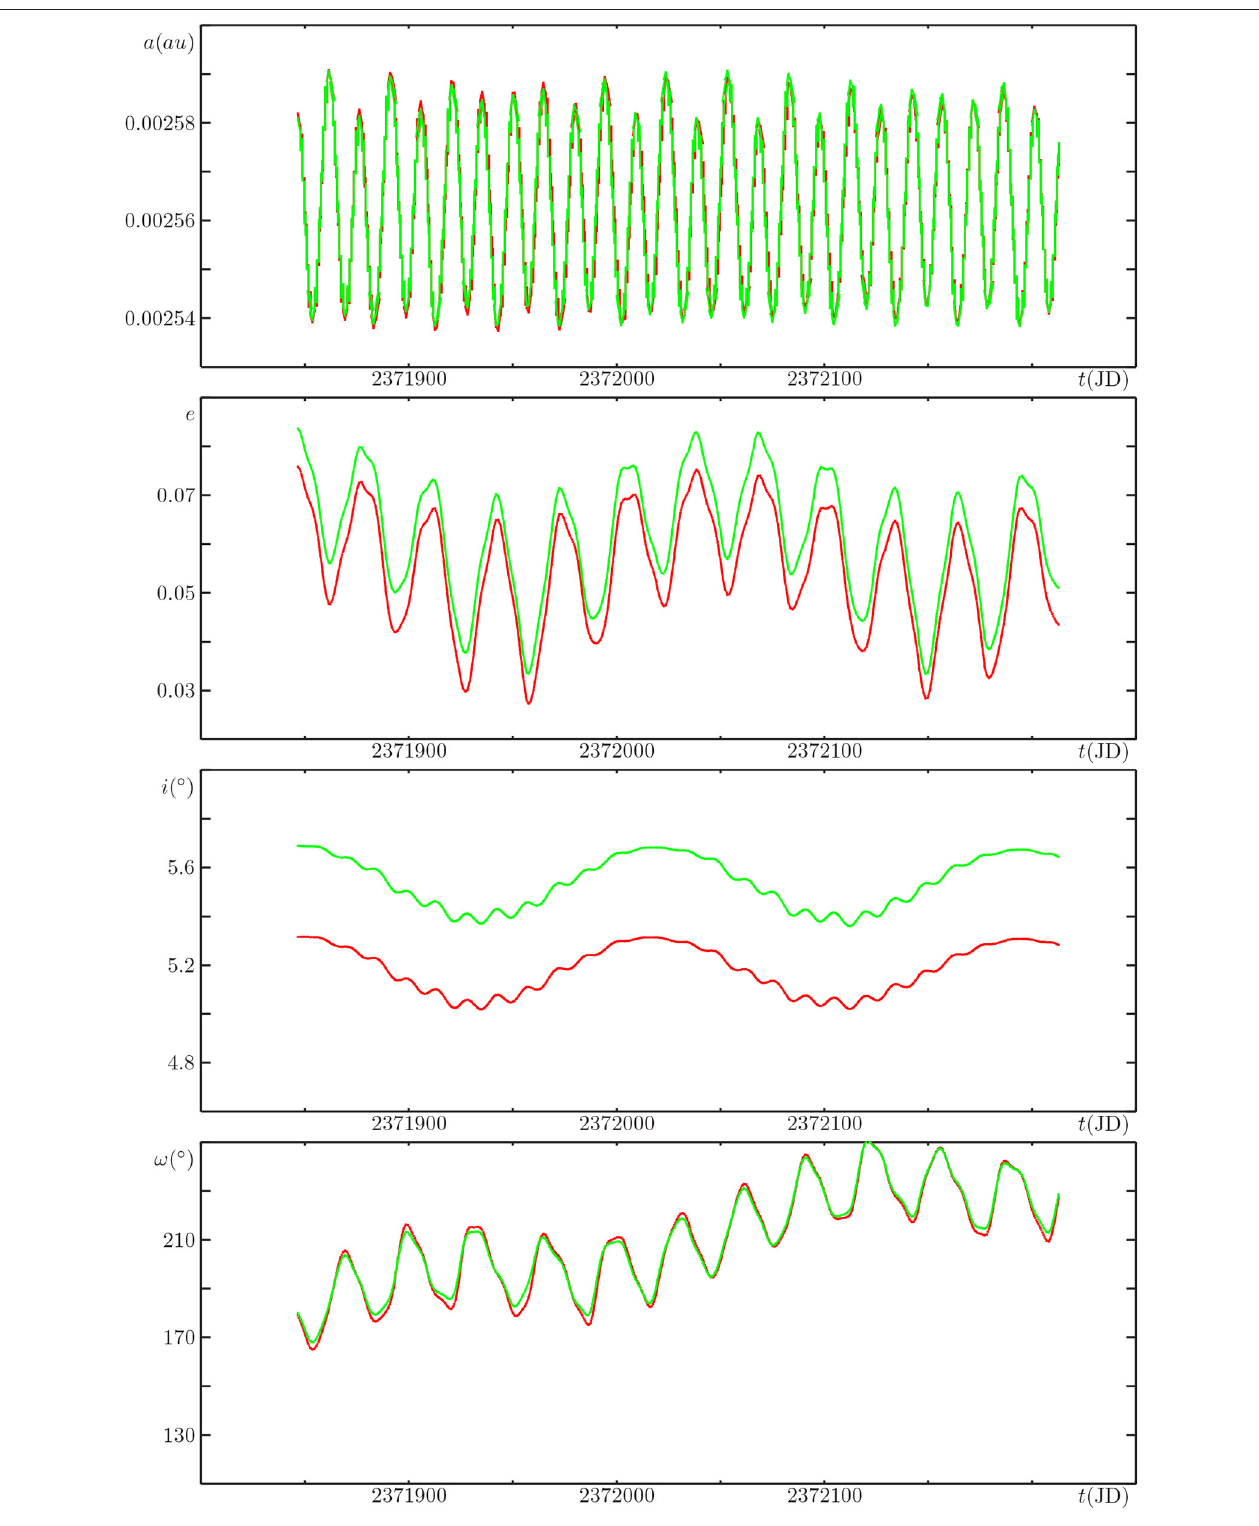
FIGURE 1 | Time evolution of the elements of the Moon taken from JPL DE406 (in red) and for the periodic orbit passing through MCs 200 and 022 (in green); top to bottom: semimajor axis a , eccentricity e , inclination i , argument of perigee ω ; the time span covered is one year, starting from 17.372 October 1781.